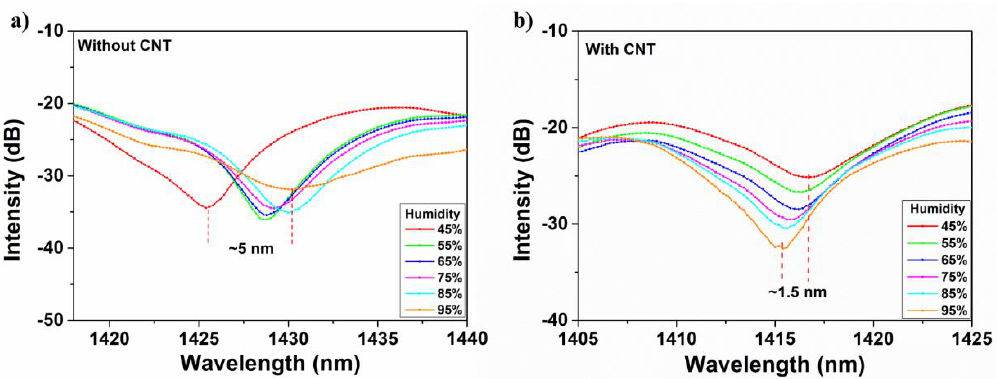
Figure 7. The spectra of relative humidity (RH) and interference wavelength without ( a ) and with ( b ) CNT attached.